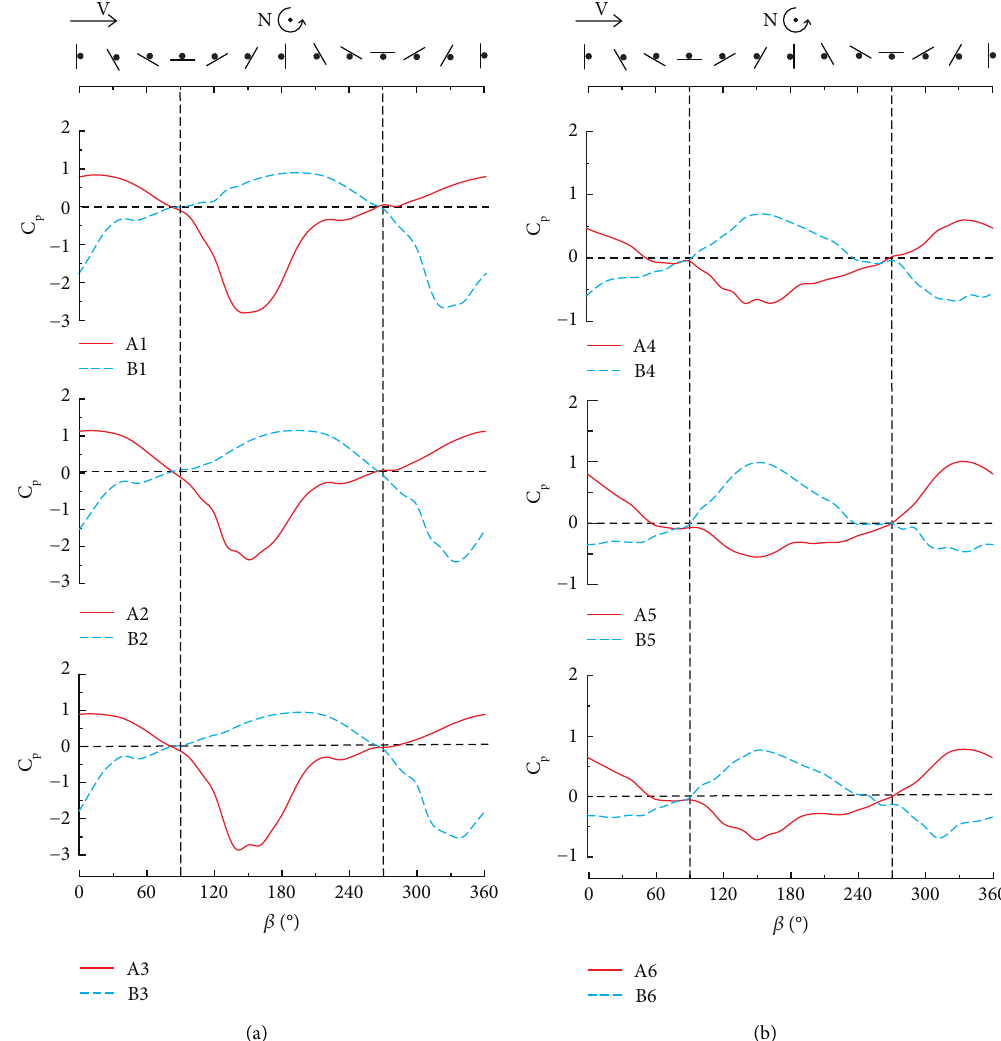
Figure 12: Pressure coefficients of the surface monitoring point with respect to azimuth angle when the solid plate antenna rotates, β � 0–360 ° , and K � 0.11. (a) Monitoring points 1, 2, and 3; (b) monitoring points 4, 5, and 6 (A represents the front and B represents the